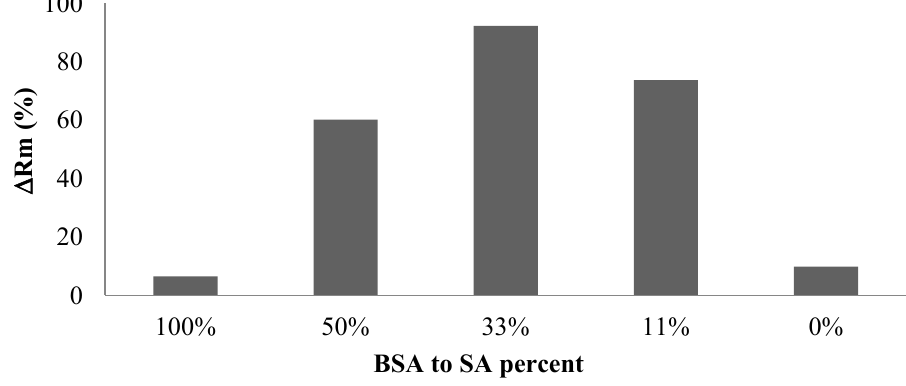
Figure 9. Effect of protein addition on irreversible